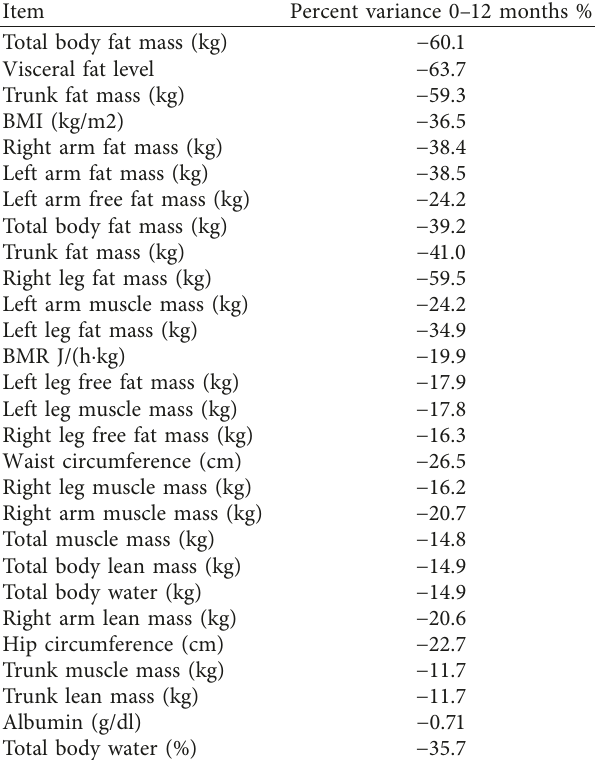
Table 3: Percent variance at 0–12 months sorted based on highest to lowest